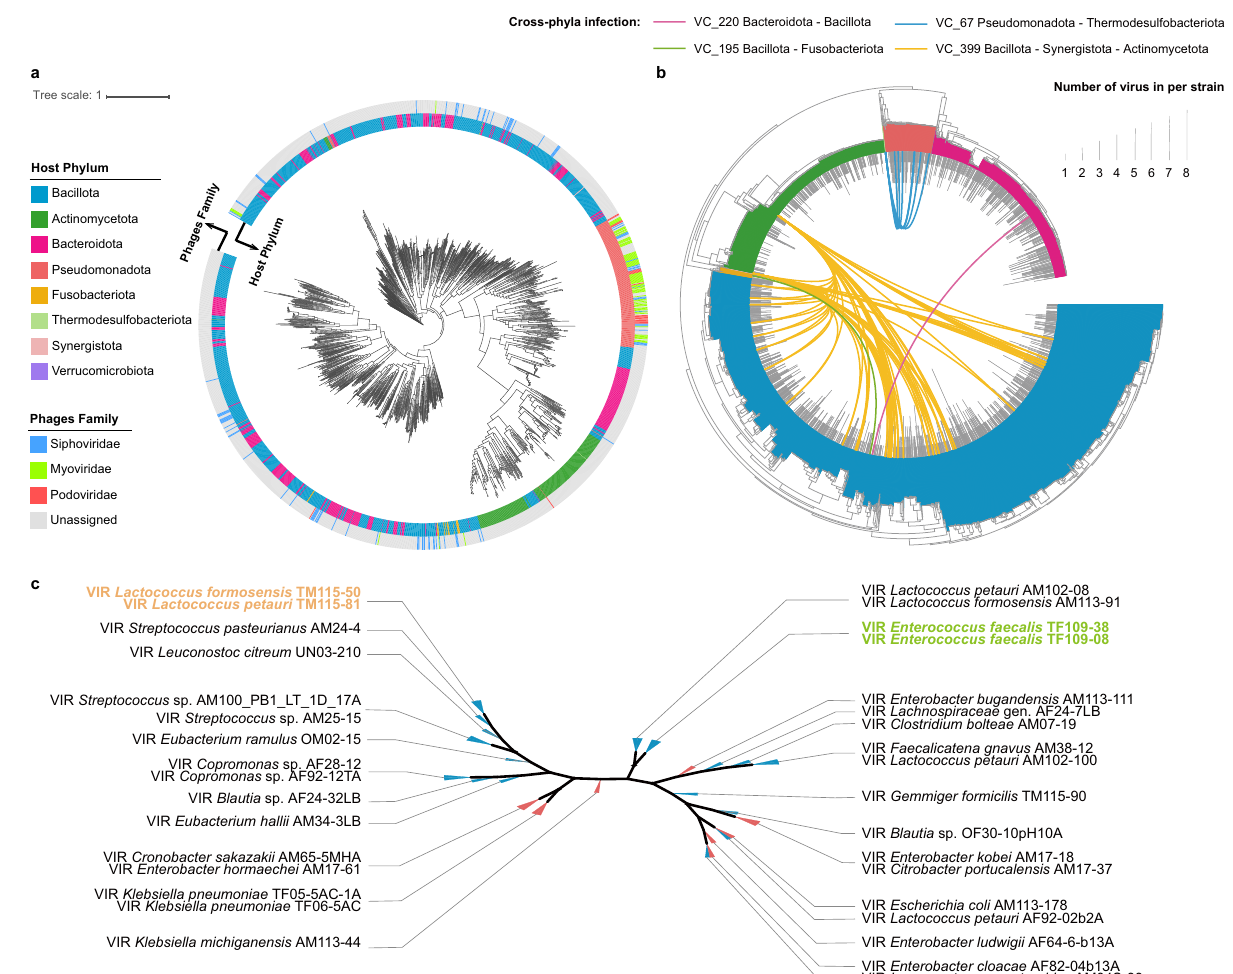
Fig. 4 | Host range of phages and interactions between phages and bacteria. a Phylogenetic tree of 1919 phage sequences. The inner circleiscolored according to the host phylum of the phages, and the outer circle is colored according to the phage family (227 phages were assigned). b Phylogenetic tree of CGR2 genomes showing phage host range. The height of the gray bars denotes the number of